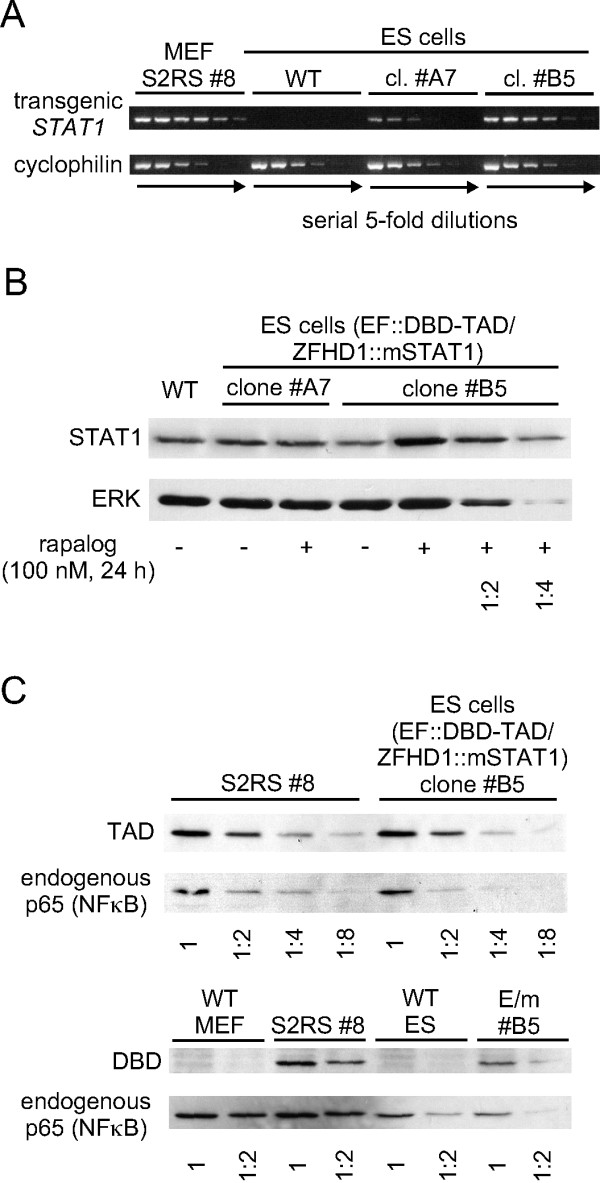
Expression analysis of inducible STAT1 and transcription factor components in double-transgenic ES cells. ES cells were stably transfected with the constructs EF::DBD-TAD and ZFHD1::mSTAT1. WT ES cells and two representative double-transgenic clones (#A7 and #B5) were treated with 100 nM rapalog or left untreated, lysed and analyzed for inducible STAT1 expression. RT-PCR was performed to detect transgenic STAT1 mRNA and normalized to cyclophilin (A). WB was performed to detect STAT1 protein as described in the legend to Fig. 2(B). Expression of the FRB-p65 fusion protein (TAD; ~48 kDa) in ES cell clone #B5 was determined by WB analysis in comparison to the S2RS #8 MEF cell line. Expression of the DBD fusion protein (~50 kDa) is shown by WB on the rapalog-binding domain FKBP12 in ES cell line #B5 and the MEF cell line S2RS #8 with respective WT cells. Endogenous p65/NFκB (65 kDa) is shown as loading control (C).